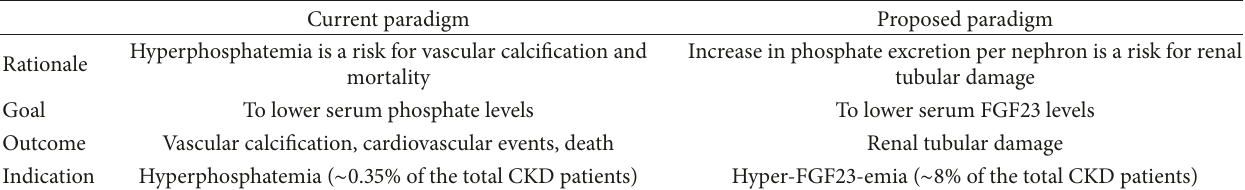
Table 2: Comparison between the current paradigm and proposed paradigm for phosphate